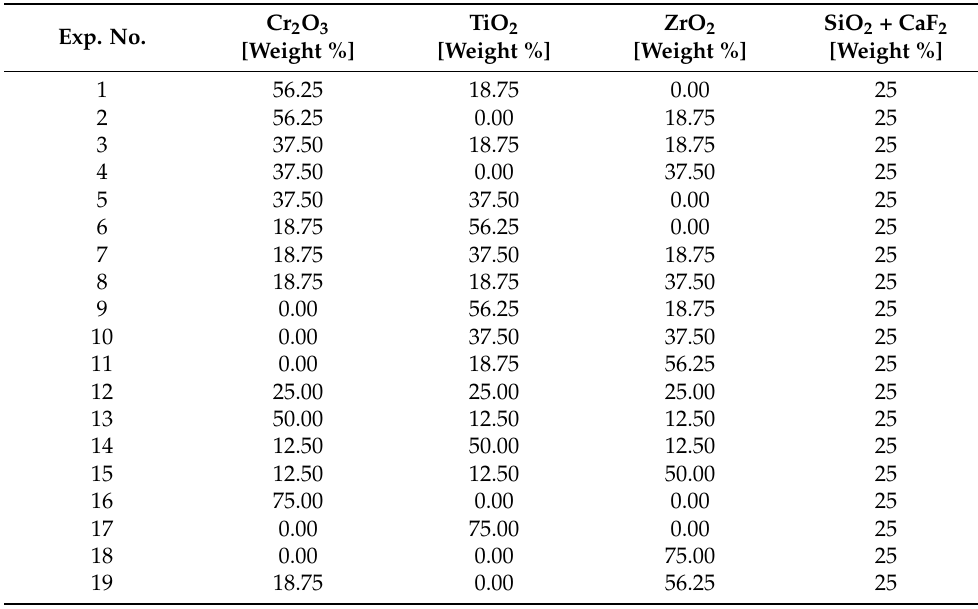
Table 4. Different pseudo-ternary combinations with the three selected oxides. Exp.